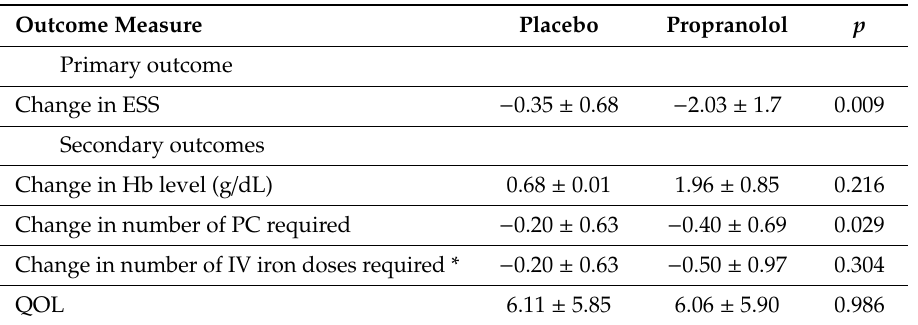
Figure 2. Demonstrating a statistically significant decrease in epistaxis severity score in the propranolol group in the randomized, double-blind phase of the trial. Table 4. Comparison of the change in outcome measures during the double-blind period among the placebo and propranolol